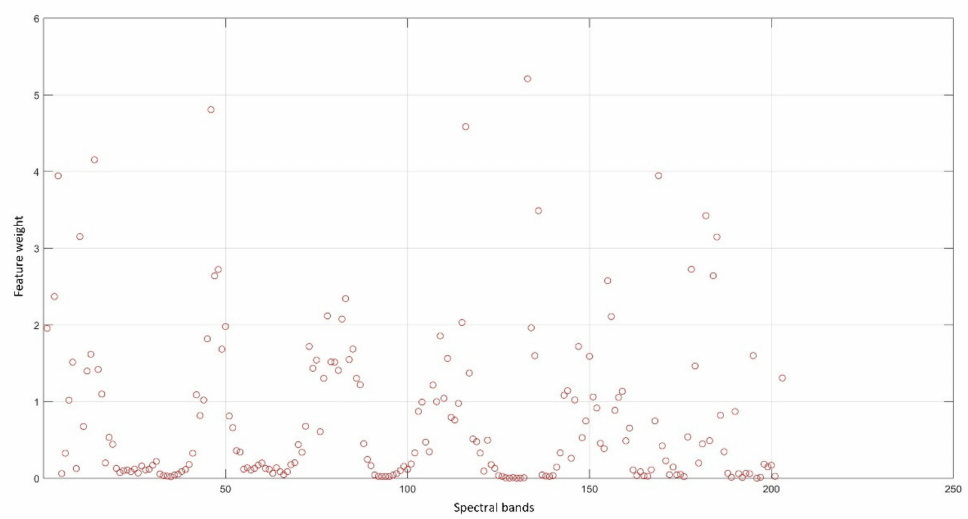
Figure 6. Neighbourhood Component Analysis feature selection which assigns higher weights to the most discriminatory hyperspectral bands by eliminating redundancy in data, with the top five feature-bands being 14, 46, 116, 133 and